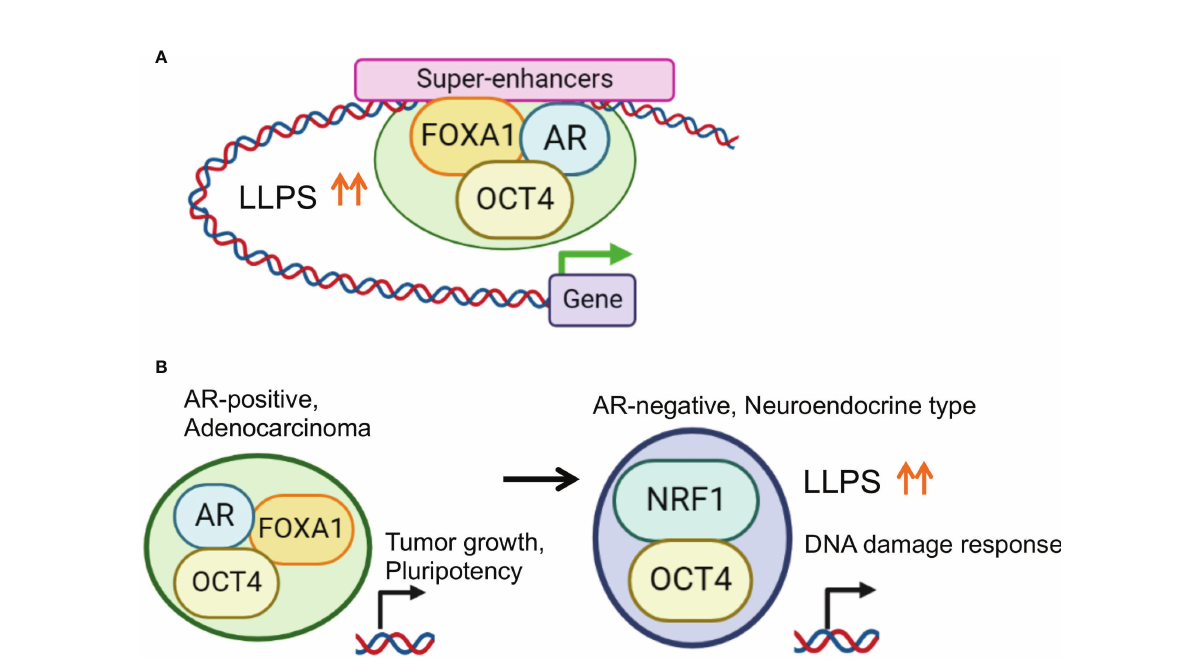
FIGURE 3 Enhanced phase-separation by transcription factor collaborations for prostate cancer progression. (A) OCT4 promotes TF complex formation by enhancing LLPS in PC speci fi c SE regions. In AR positive PC cells, OCT4 interacts with AR, FOXA1 and activates SEs to induce important